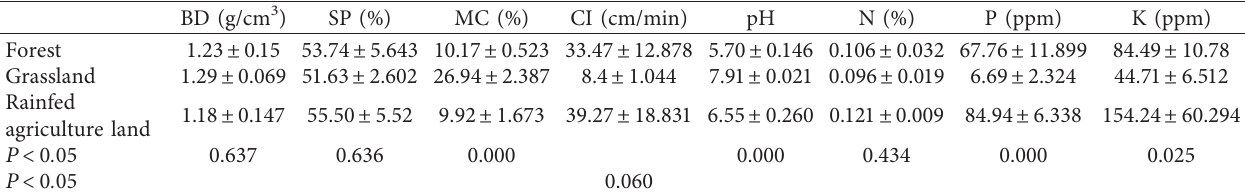
Table 1: Effect of land use system on soil